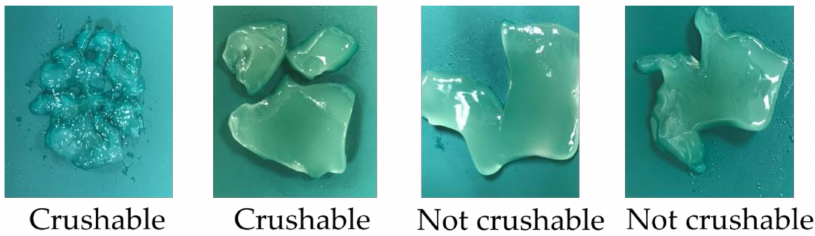
Figure 1. Criteria to determine the crushability of test food.